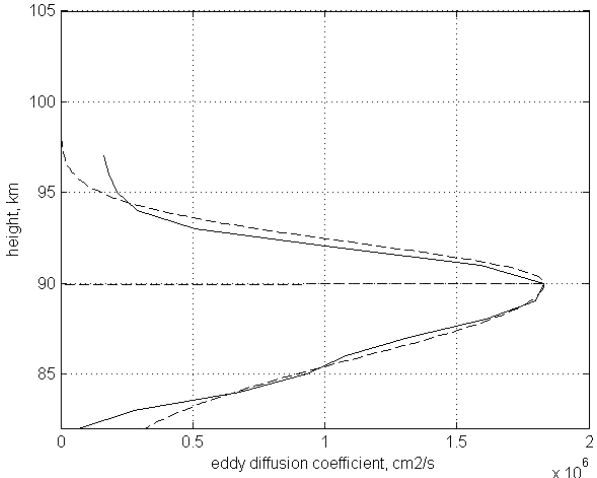
Fig. 9. Height profile of the eddy diffusion coefficient measured by Lübken (1997) in the polar region (solid curve) and approx- imated by Eq. (5) (dashed curve) with parameters K m 10 6 cm 2 s − 1 and z m = 90km, shown by the horizontal line.